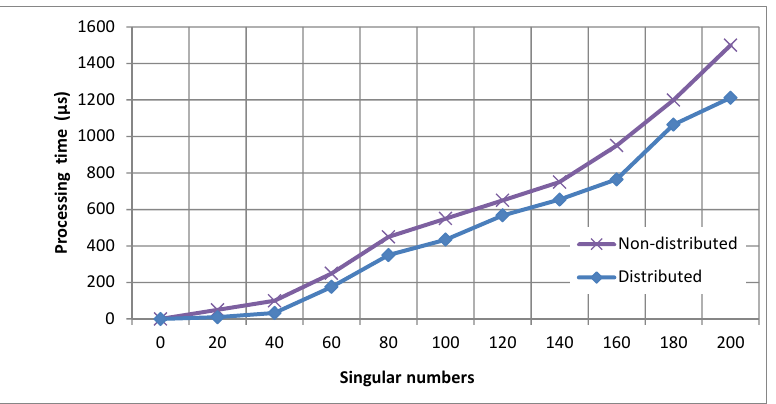
Figure 13. The dependence of the processing time of calculations of the data matrix of rank 200 on the number of singular numbers in distributed and non-distributed systems.